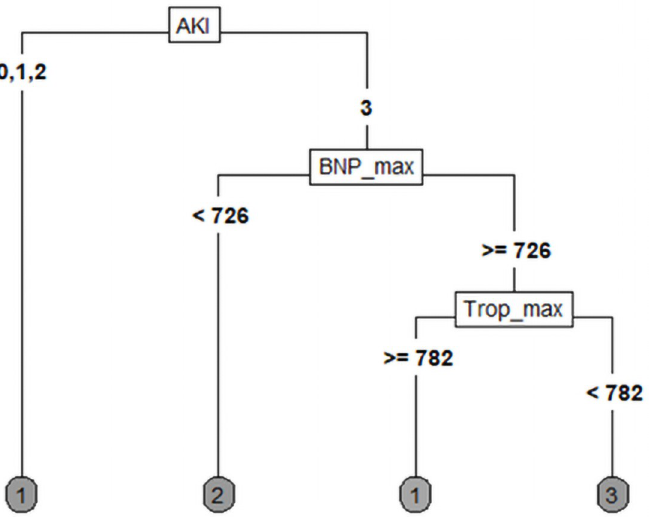
Fig 5. CKD outcome determined by AKI. AKI acute kidney injury, maximum NTproBNP value, and maximum troponin T value. 1: Recovery, 2: Remaining or worsened CKD, 3: KRT.